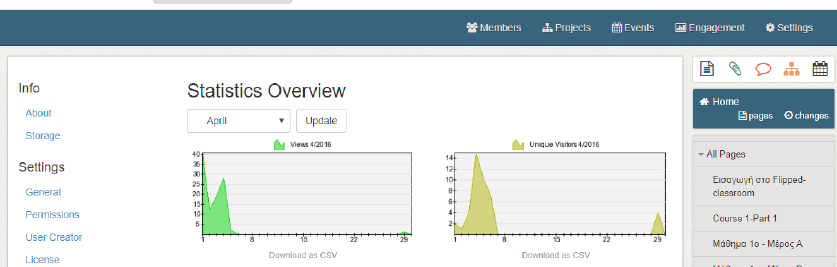
Fig. 4. Diagram 'Views 4/2016': Users’ visits on the wiki on particular dates & Diagram 'Unique visitors 4/2016': Number of users (visitors) accessing the wiki on particular